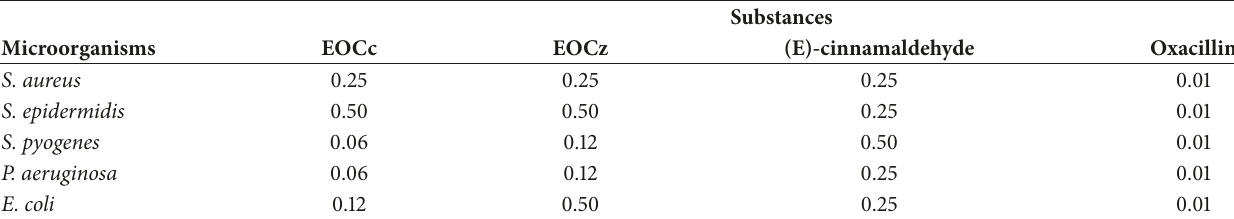
Table 3: Minimum concentration of essencial oil from C. cassia (EOCc) and C. zeylanicum (EOCz) stems, (E)-cinnamaldehyde and oxacillin (mg/ml) reduce biofilm biomass by 100% in comparison to normal biofilm